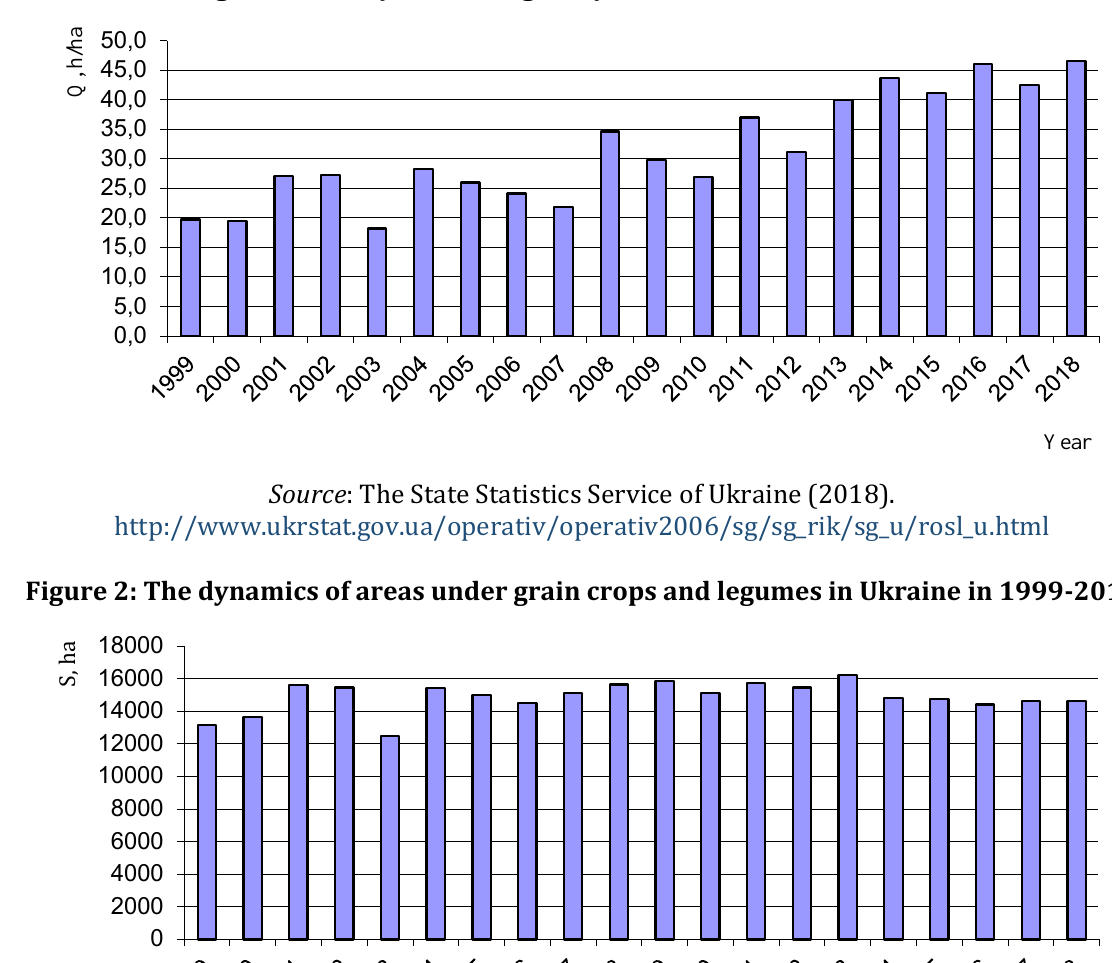
Figure 1: The dynamics of grain yield in Ukraine in 1999-2018